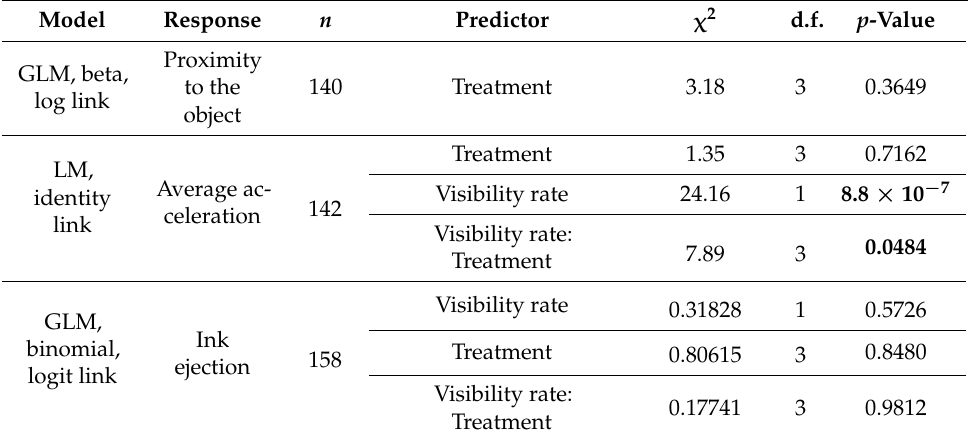
Table 2. Results from statistical analyses, depicting the effect of the treatments (control, acidification, warming, and acidification and warming combined) on locomotory and exploratory behaviors of Sepia officinalis